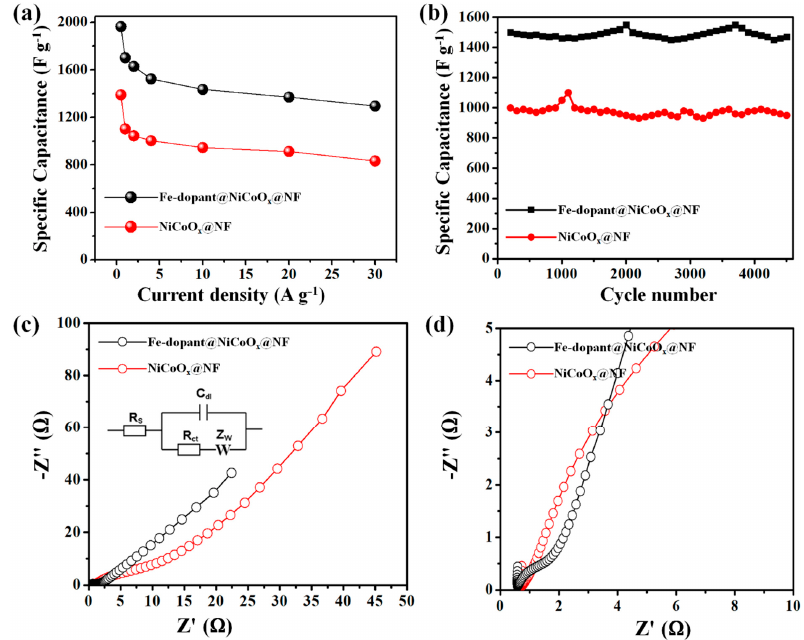
Figure 7. Electrochemical behavior of the as-developed electrodes in a three-electrode configura- tion: ( a ) Specific discharge capacity for as-fabricated NF, NiCoO x @NF nanowires, and Fe-dopant@NiCoO x @NF nanoneedle composite electrodes measured at diverse specific current, ( b ) cyclic stability properties, ( c ) EIS plots of the prepared electrodes (inset: fitted equivalent circuit), and ( d ) EIS plots of the enlarged high-frequency region.